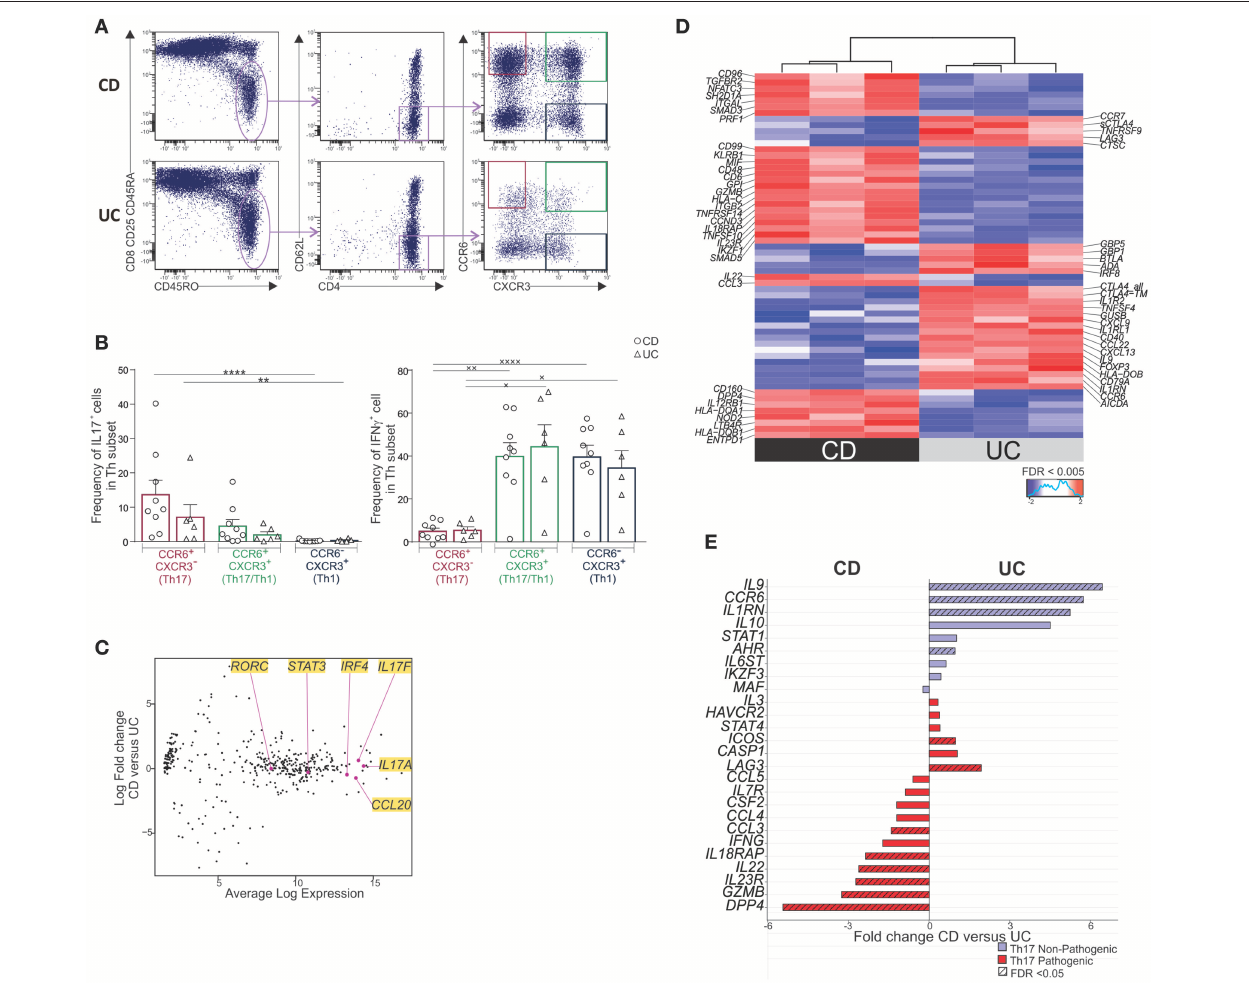
FIGURE 2 | MLN Th17 T EM cells of CD differentially express a pathogenic/cytotoxic molecular profile relative to UC. (A) Gating strategy for sorting CCR6 ± CXCR3 ± T EM subsets in mLN. Cells were activated with anti-CD3/anti-CD28-beads for 6 days. On the last day, PMA-ionomycin was added for 6h and Brefeldin A for the last 3h. (B) Frequencies of IL17 and IFN γ -expressing cells by intracytoplasmic staining in sorted Th T EM subsets. (C–E) Cells were activated with anti-CD3/anti-CD28-beads for 6 days. Molecular profiling of mLN Th17 T EM cells in CD ( n = 3) and UC ( n = 3) by Nanostring. (C) Expression of key Th17 genes in CD vs. UC. (D) Heatmap of differentially expressed genes in CD relative to UC (FDR < 0.005). (E) Fold change of Th17-associated pathogenic and non-pathogenic genes. Friedmann test followed by Dunn’s test (*) and one-way ANOVA followed by Tukey’s test ( × ). × P < 0.05, ** , ×× P < 0.01, and **** , ×××× P <